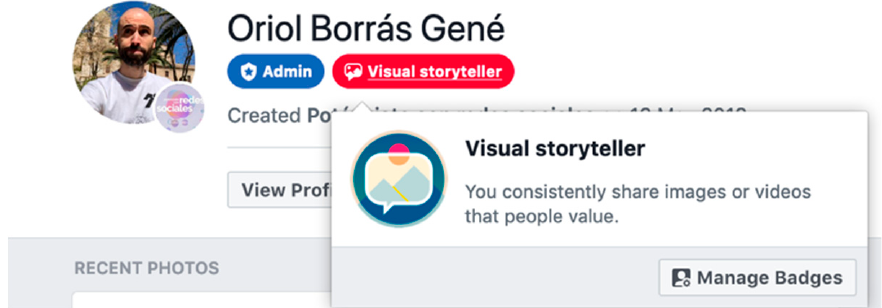
Figure 2. Digital badges in Facebook Groups.